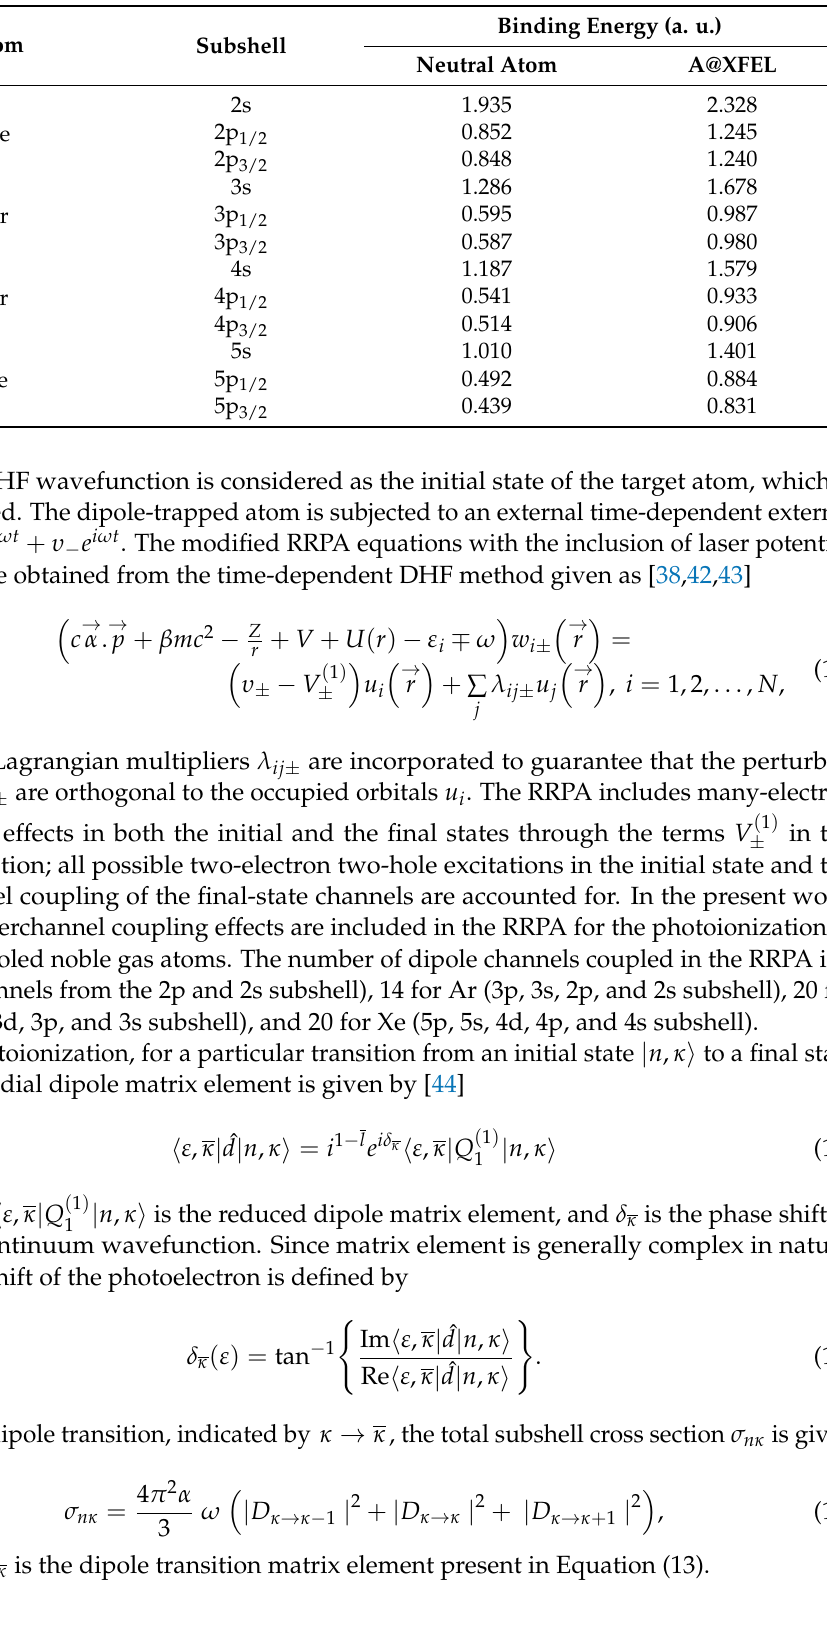
Table 1. Binding energy of valence subshells of neutral atom and